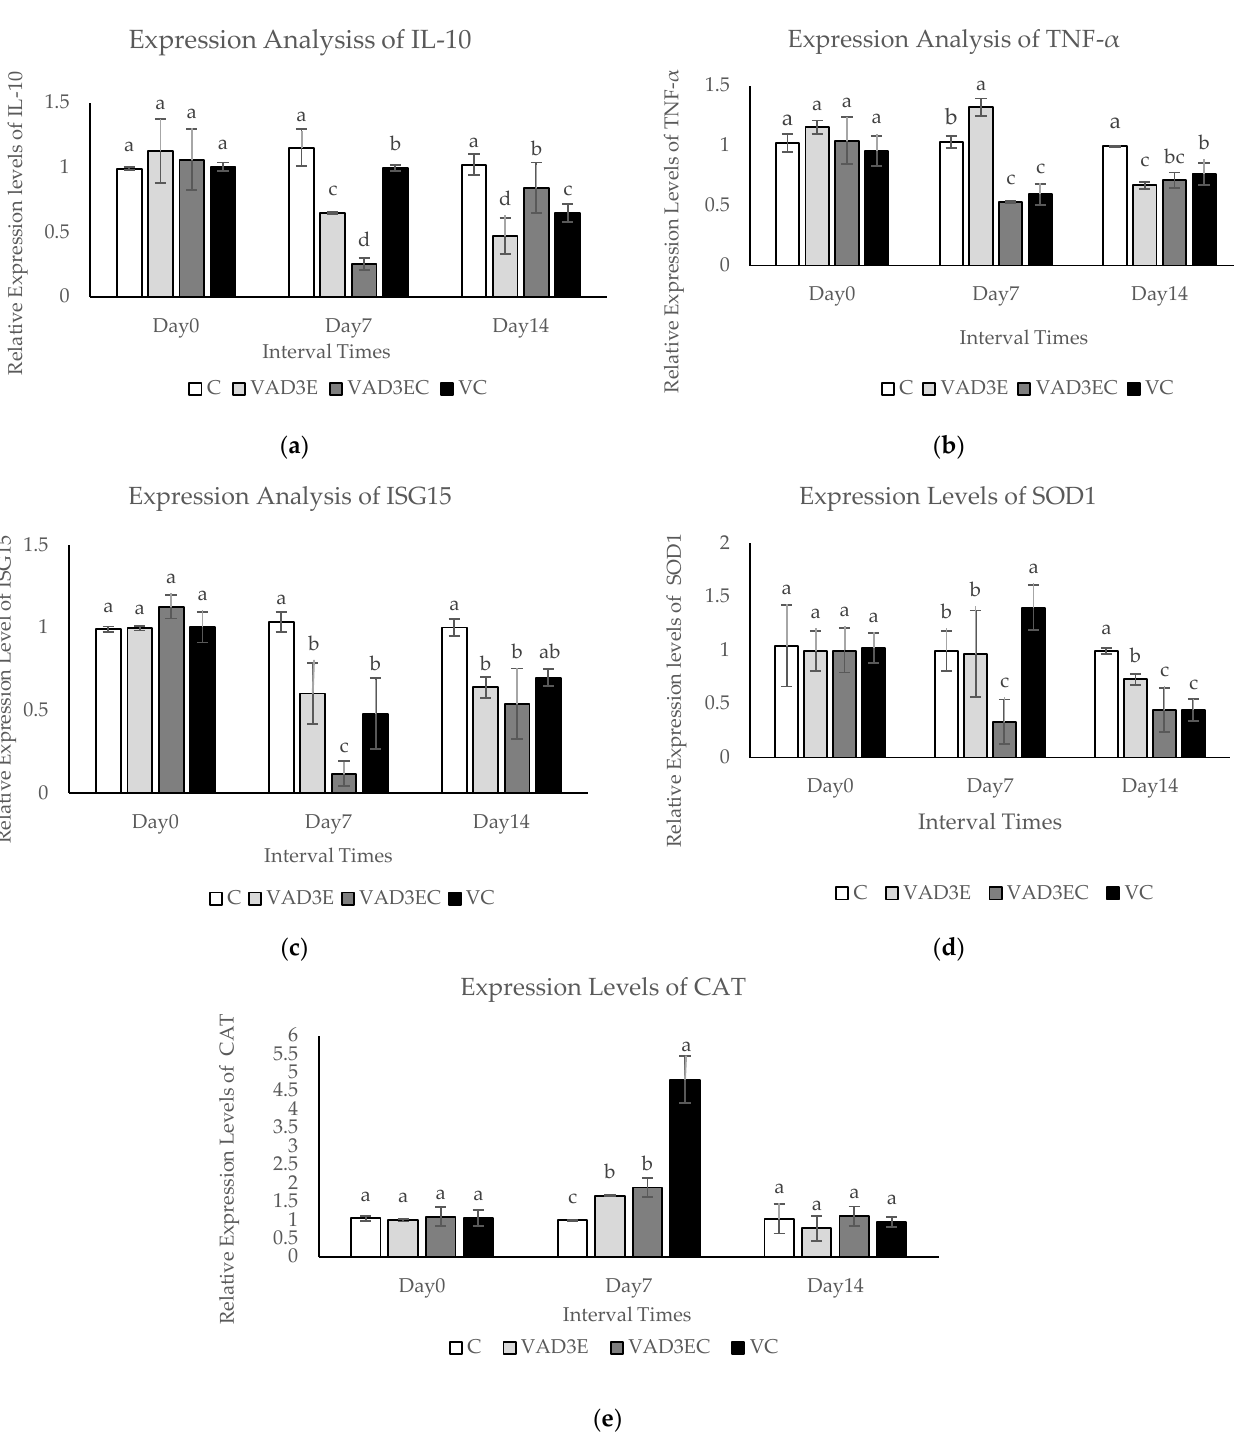
functions and normal reproduction in dairy cows. This study found that the percentage of estrus detection, the rate of conception, and the rate of pregnancy were not significant factors in any treatment group, suggesting that the estrous behavior, conception rate, and pregnancy rate were not affected by the administrated vitamins. Likewise, Maldonado et al. [19] reported that vitamins C and E did not significantly increase the pregnancy rate in their cows. Yildiz et al. [20] showed that the administration of a single subcutaneous injection of vitamin E and selenium just before Ovsynch testing had no significant effect on the conception rates of dairy cows. However, the application of those vitamins affected the GPx and SOD activities and progesterone levels. On the other hand, Sarker et al. [21] illustrated that the administration of vitamin AD3E or vitamin minerals induced cyclicity and conception in a higher proportion of anestrus heifers compared to the control group. A study in buffalos found that injections of vitamin AD3E resulted in a 37.5% conception rate compared to 12.5% in the control group [22]. Nutritional deficiency or imbalance was believed to be a primary cause of anestrus, and supplementation of vitamins should be considered for real anestrus [22]. Regarding hematological parameters, this study found that vitamins AD3E and C had an impact on WBC, Neu, Lin, and PLT. Among VAD3EC-treated cows, the highest values were observed for WBC and Lin parameters. The PLP values were considerably impacted by vitamin C, as evidenced by the highest PLP value being observed in VC- treated cows. However, Neu exhibited the highest percentage (51.80%) in the control group. Meanwhile, RBC, Ht, Hgb, MCV, MCHC, Eos, and Mon values did not show any significant changes (refer to Table 3). A similar finding has been documented by other researchers. Mohammed et al. [23] demonstrated the role of vitamin AD3E in regulating incentive hormones during ovulation. The function of estrogen hormone release is to